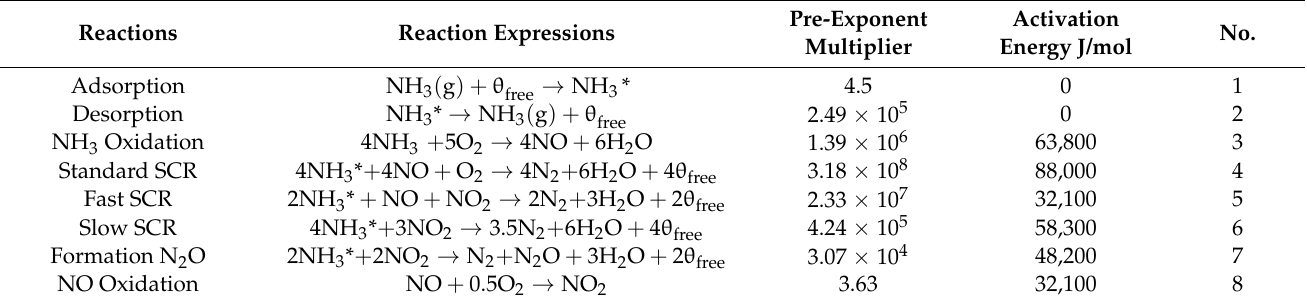
Table 6. Main reactions and expressions in SCR catalytic converters.